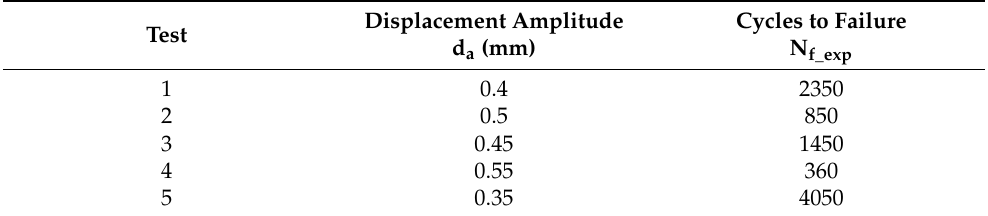
Table 5. Parameters and number pf cycles of LCF tests at R d =